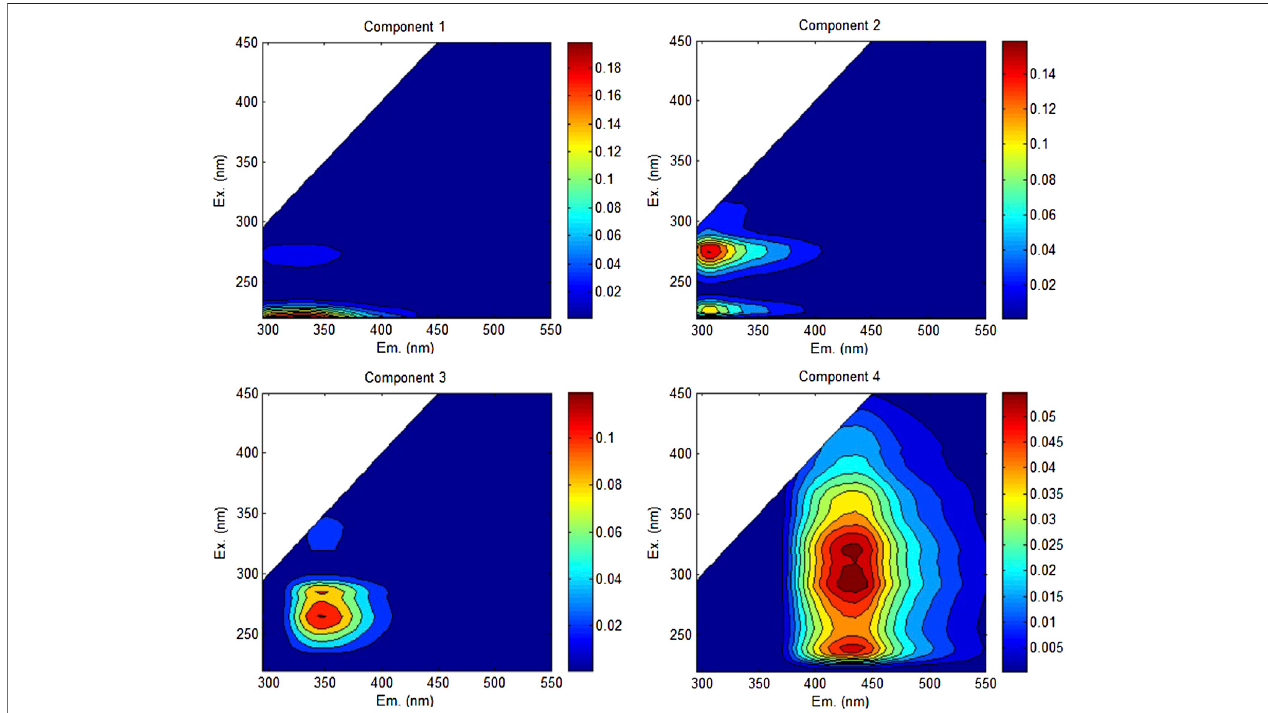
FIGURE 1 | Calculation of DOM fl uorescence component extraction residue by the PARAFAC model.